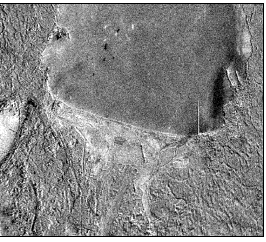
Figure 8. The absolute difference image of images before and after the disaster